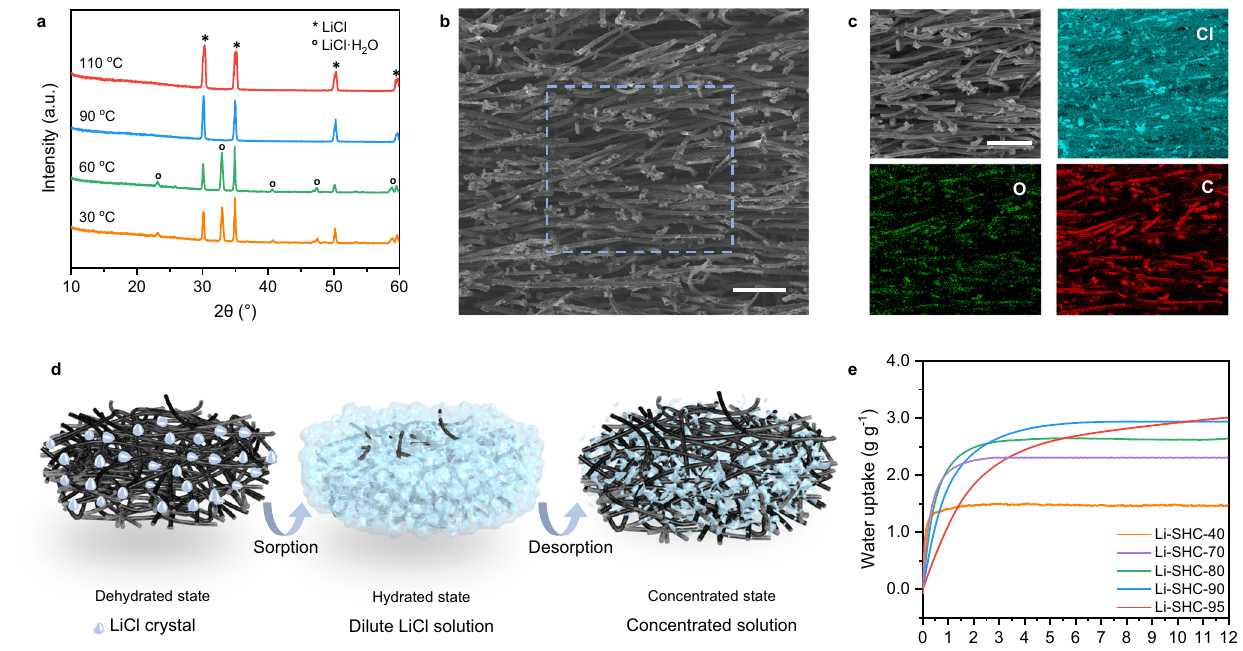
Fig. 1 | Characteristics and optimization of Li-SHC. a Variable temperature XRD patterns of porous matrix and sorbents. b SEM images of Li-SHC with the salt contentof90wt%inthesectionalview.Scalebar:100 μ m. c EDSelementmapping of Li-SHC demonstrates the uniform nanoscale arrangements of LiCl crystals and smallamounts of agglomeration. Scale bar: 100 μ m d Schematic illustrationof the